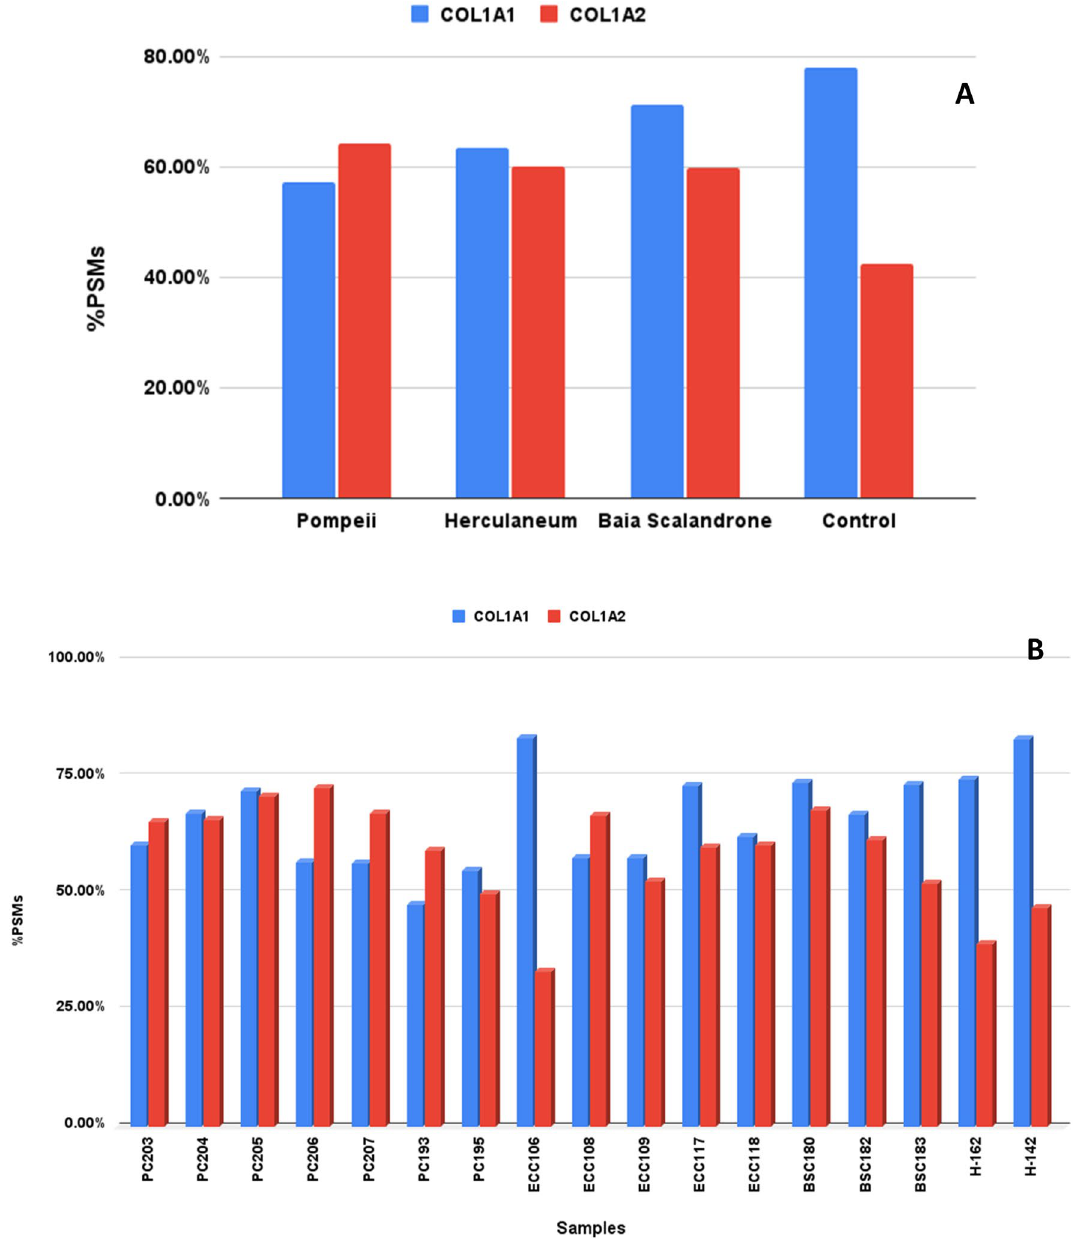
Figure 2. Backbone cleavages in collagen alpha 1(I) and collagen alpha 2 (I) in bone samples from Pompeii, Herculaneum, Baia Scalandrone and control (H-162, H-142 34 ). Overall occurrence per samples groups ( A ) and in the single samples ( B ), evaluated as percentage of peptide-spectrum matches (PSMs) of semitryptic peptides over the total number of peptide-spectrum matches (tryptic plus semitryptic